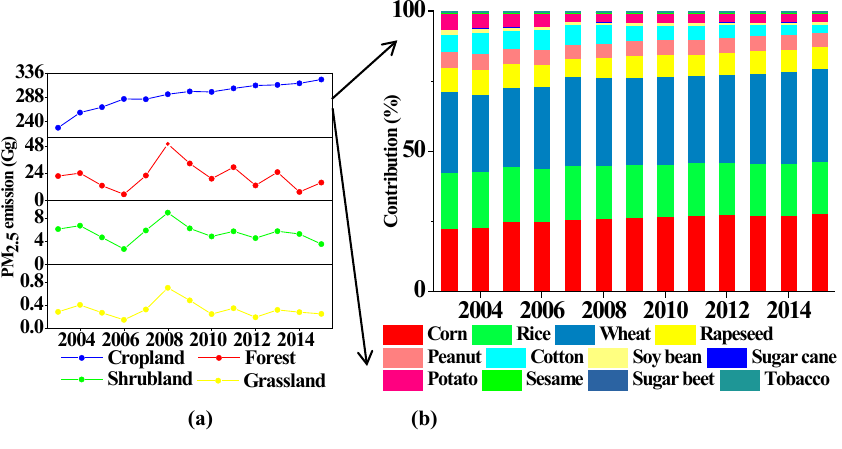
Figure 6. The multi-year PM 2 . 5 emissions of different opening biomass burning sources (a) and various crop types (b) from 2003 to 2015.